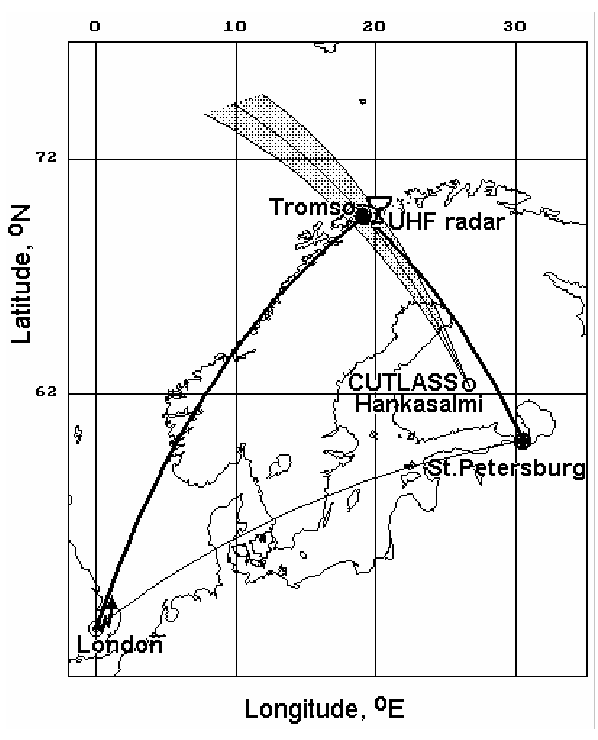
Fig. 1. Map showing the experiment geometry. Bi-static HF Doppler radio scatter observations were carried out on the London- Tromsø-St. Petersburg paths (thick lines). The London-St. Peters- burg direct path is shown on the map by a thin line. The viewing geometry of the Hankasalmi CUTLASS HF coherent scatter radar is also presented on the